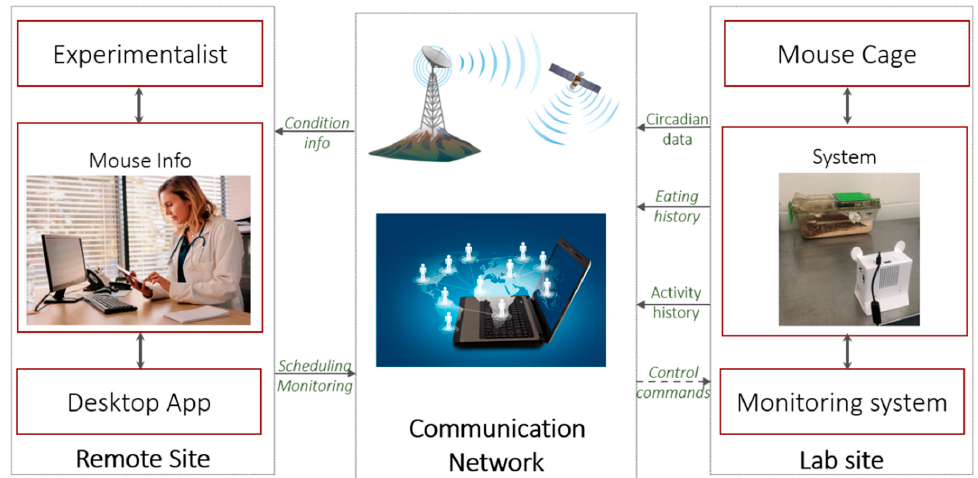
Figure 1. Schematic representation of CageView, including the system, tested in the laboratory of the University of Manitoba Department of Animal Science ( right box ), schematic of the communication system ( middle box ), and the experimenter’s desktop-based site in the remote location ( left box ).